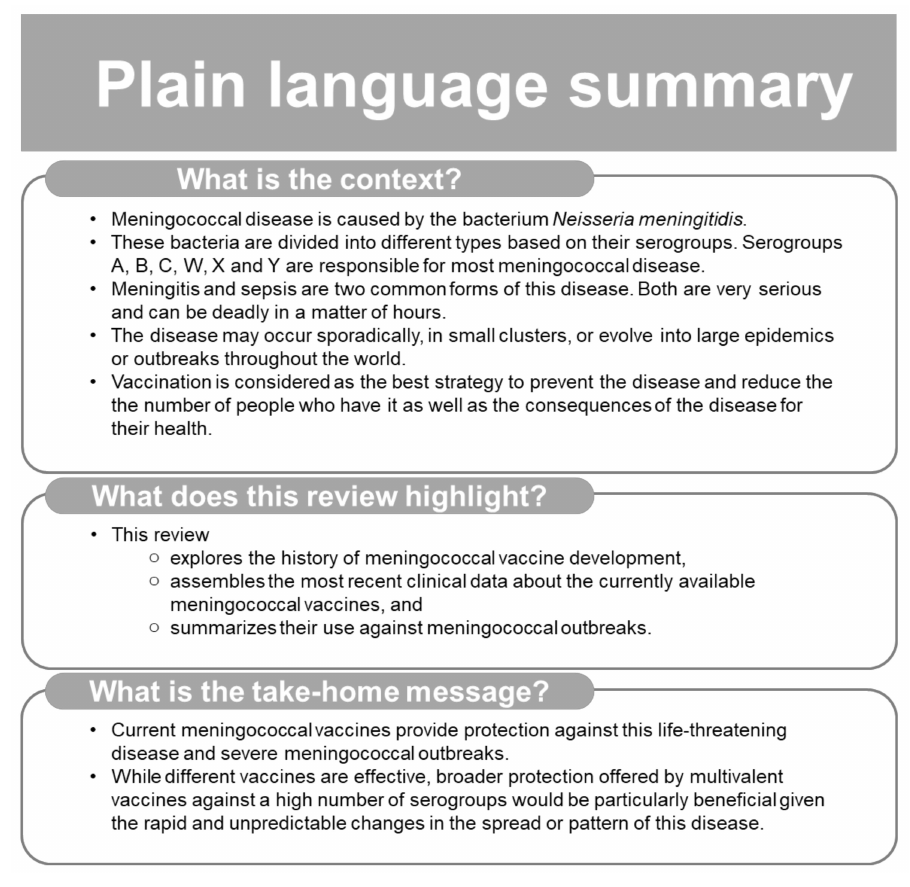
Figure 1. Plain language